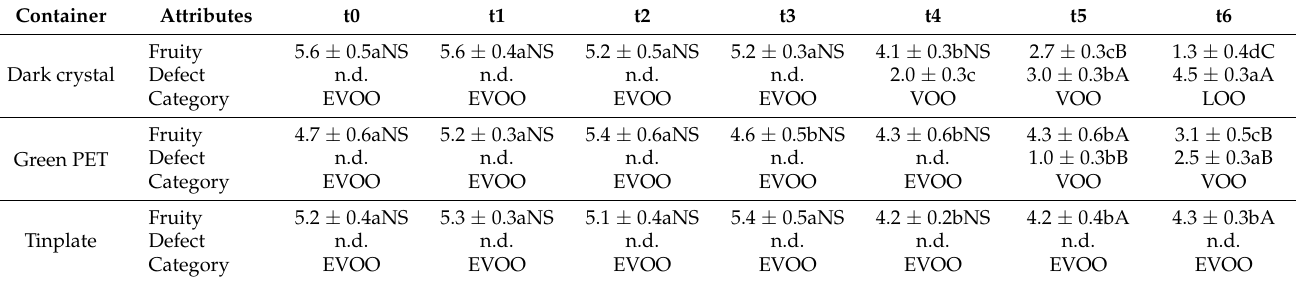
Table 1. Most common sensory attributes identified through panel testing (mean ± standard de- viation), split by commercial category of EVOO and packaging in different container types over 21 months of storage. The small letters refer to significant statistical differences (Tukey’s Test, p < 0.05) according to the storage time (t0–t6) for each container type. The capital letters represent significant statistical differences (Tukey’s Test, p < 0.05) according to the different container types (dark crystal, green PET and Tinplate) relative to storage time (t0–t6).